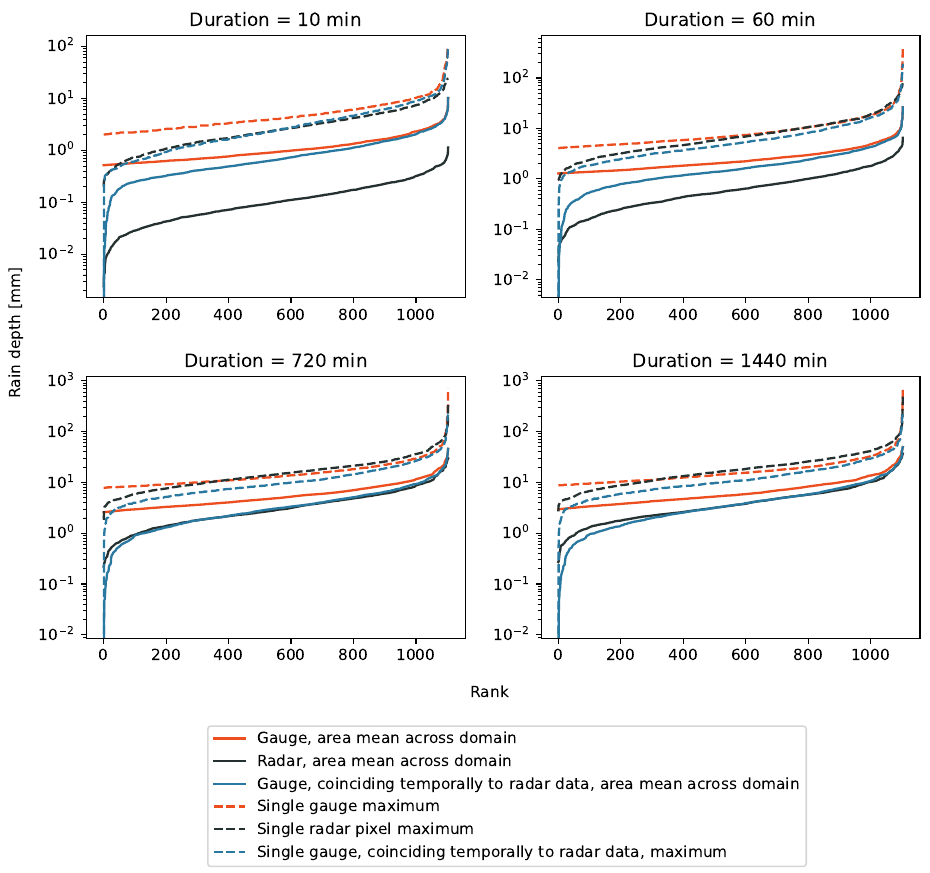
Gauge, area mean across domain Radar, area mean across domain Gauge, coinciding temporally to radar data, area mean across domain Single gauge maximum Single radar pixel maximum Single gauge, coinciding temporally to radar data, Figure 2. Ranked maximum point (dashed lines) and transposition domain average (solid lines) rainfall depths for short-term rain-gauges (orange) and generated radar-data storm catalogs (black). Blue lines show the short-term gauge dataset adjusted so that the dates coincide with the radar